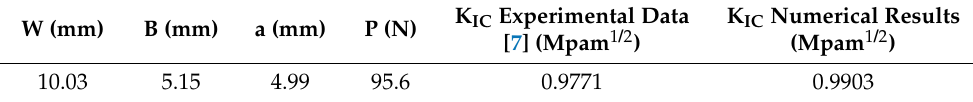
Table 4. Comparison of experimental and calculated values of mode I fracture